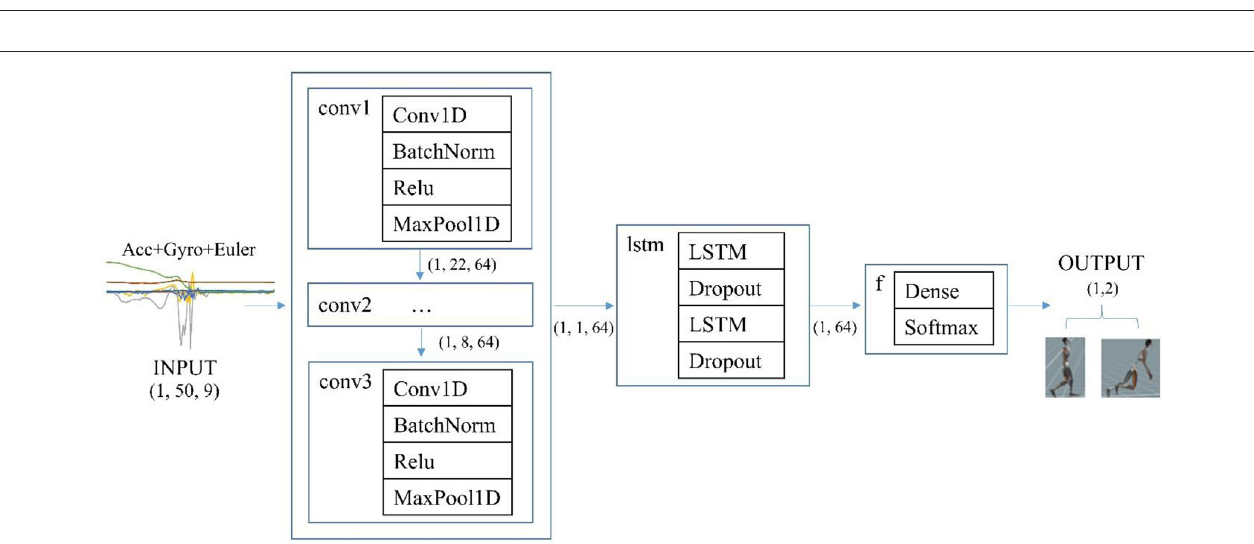
FIGURE 6 | A flowchart of the threshold-based algorithm for pre-impact fall detection.